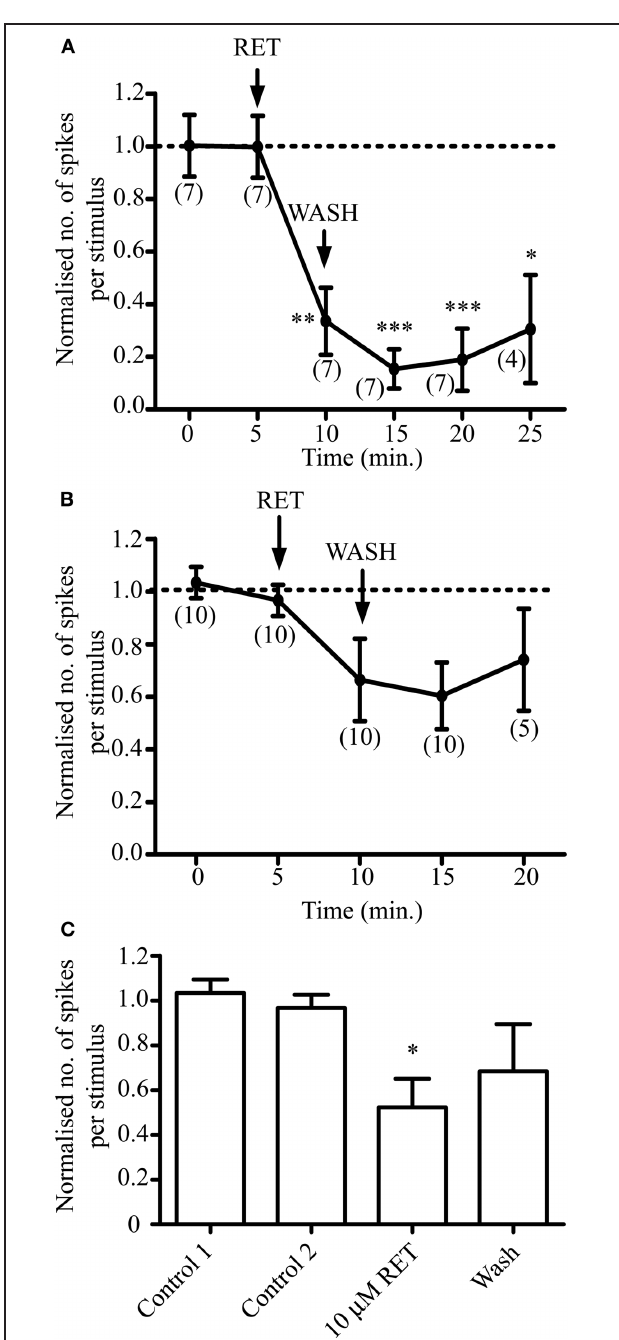
FIGURE 3 | Opening M-channels in sensory endings with retigabine (RET) strongly dampens AMH-fiber responses to noxious heat but has less effect on C-fibers. Normalized responses to noxious heat in AMH-fibers (A) and C-fibers ( B and C ). Normalization is to the mean of the two control responses prior to retigabine exposure. AMH-fiber responses were significantly inhibited by 10 μ M retigabine ( ∗ P < 0 . 05, ∗∗ P < 0 . 01, ∗∗∗ P < 0 . 005). (C) C-fiber minimal responses to heat measured at either 5 or 10min following exposure to retigabine were significantly reduced ( ∗ P < 0 . 05) compared to control. Number of fibers shown in brackets. AMH- and C-fiber mean conduction velocities were 3.98 ± 0.99ms − 1 ( n = 7) and 0.65 ± 0.09ms − 1 ( n = 10),